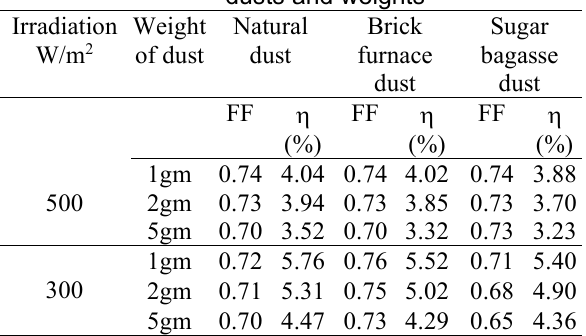
Table 8. Comparison of FF and η for different